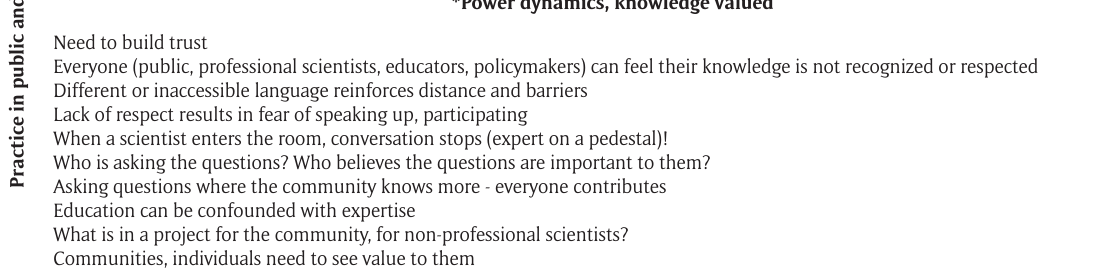
Table 2: Compilation of observations from the CSA 2015 symposium Pathways to balance and partnership: advancing equity, inclusion, and local relevance in citizen